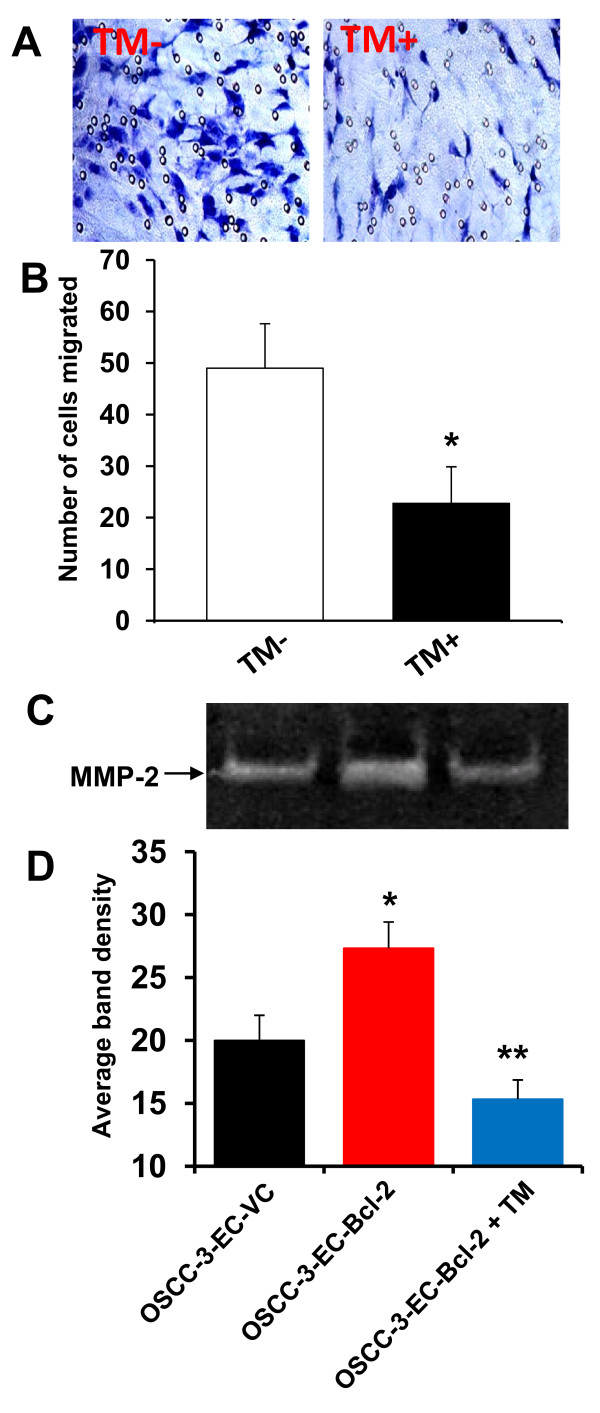
TM treatment significantly inhibits oral squamous cell invasiveness. TM effect on tumor cell invasiveness was examined by Matrigel invasion assay. A; representative photomicrographs of invaded cells with (TM+) or without TM (TM-) treatment.B; number of tumor cells that had invaded through the Matrigel were counted in 5 high power fields. *, represents a significant difference (p < 0.05) as compared to the control group. C; Culture supernatants from OSCC-3 cells co-cultured with EC-Bcl-2 or EC-VC were resolved using 10% polyacrylamide gelatin gels. After electrophoresis, the gels were developed and stained by 0.5% Coomassie Brilliant Blue R-250 solution to visualize the bands. D; the band density was measured and expressed as average band density. *, represents a significant difference (p < 0.05) as compared to the OSCC-3-EC-VC group and **, represents a significant difference (p < 0.05) as compared to the OSCC-3-EC-Bcl-2 group.